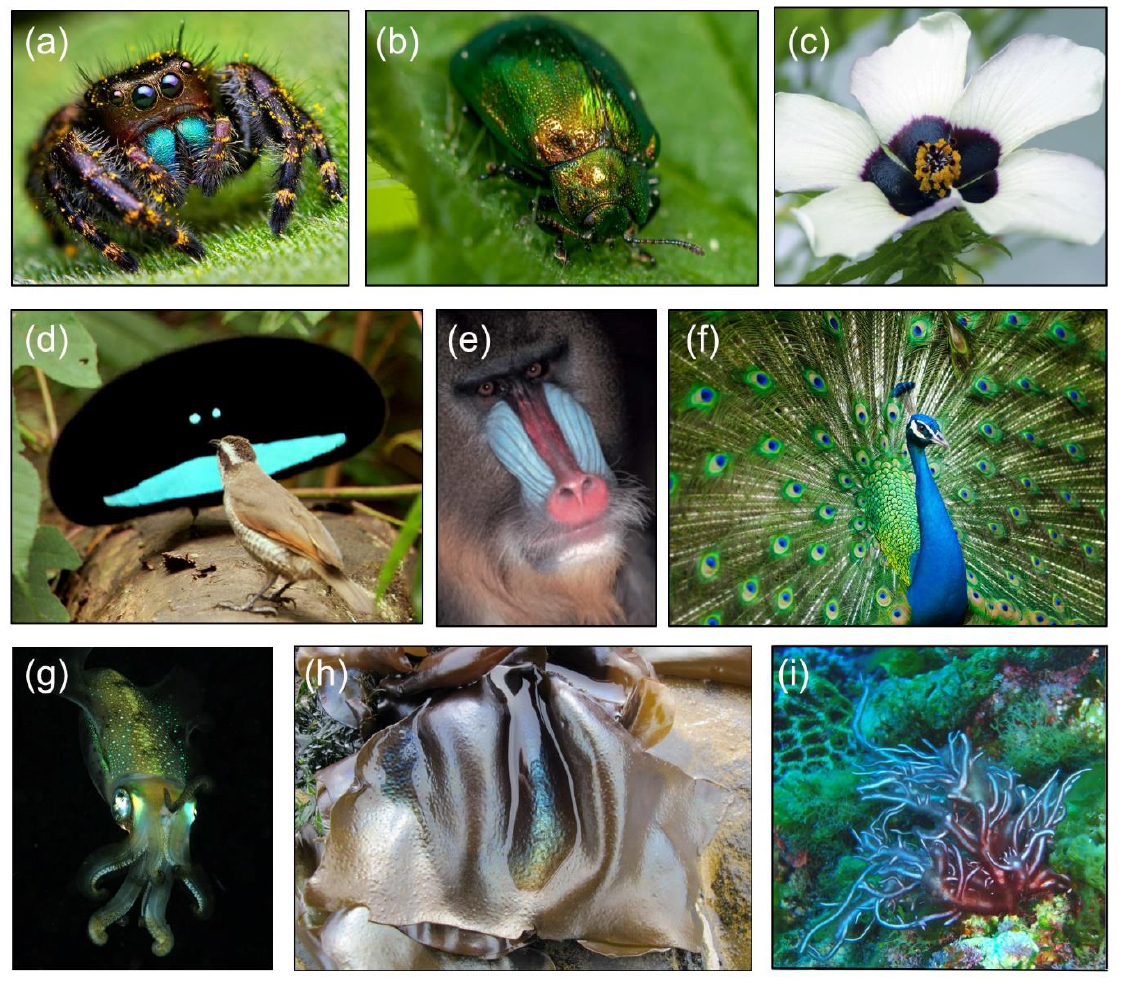
Figure 1. Examples of structural color in eukaryotes. ( a ) Female jumping spider Phidippus audax (Photo: T. Shahan). ( b ) Dogbane beetle, Chrysochus auratus (Photo: P. Ganai). ( c ) Hibiscus trionum flower (Photo: E. Moyroud). ( d ) Male superb bird of paradise, Paradisaea rudolphi . ( e ) Male mandrill, Mandrillus sphinx . ( f ) Male Indian peafowl (peacock), Pavo cristatus . ( g ) Bigfin reef squid (or glitter squid), Sepioteuthis lessoniana . ( h ) Red macroalgae, Iridaea cordata (Photo: J. Brodie). ( i ) Red macroalga, Trichogloea spp. (Photo: G. Saunders).